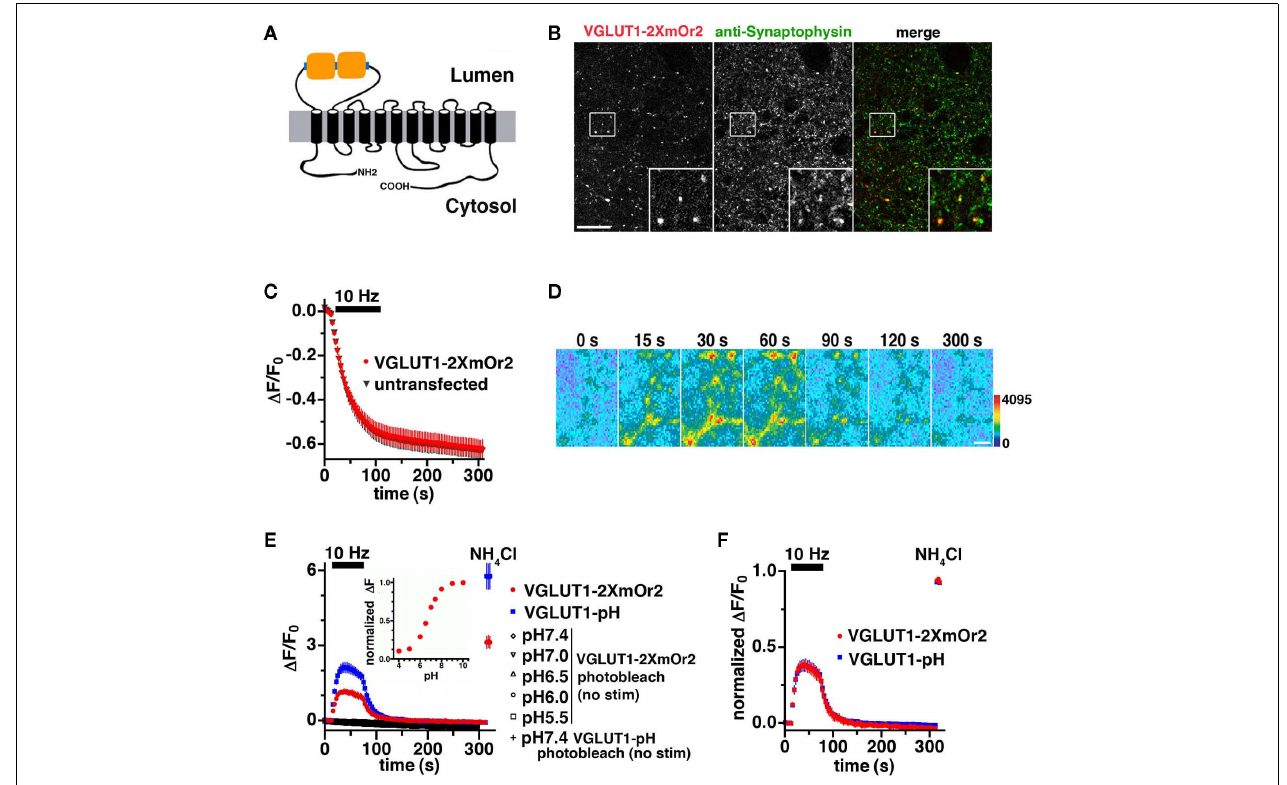
Scale bar, 2 μ m. (E) The change in fluorescence intensity over baseline ( Δ F / F 0 ) at boutons expressingVGLUT1-pH (blue) is approximately twice that ofVGLUT1-2XmOr2 (red) during stimulation at 10Hz for 60s (bar). Photobleaching over the time course of the experiment was measured by imaging in the absence of stimulation at a range of pH values (black symbols). Photobleaching ofVGLUT1-2XmOr2 (open diamonds) was similar to that ofVGLUT1-pH ( + symbol) at pH 7.4. Inset: normalized fluorescence change ofVGLUT1-2XmOr2 over the range of pH 4.0 to 10.0 in permeabilized cells indicatesVGLUT1-2XmOr2 exhibits a p K a of 6.71. (F) Kinetics of fluorescence changes normalized to total fluorescence signal in the presence of NH 4 Cl are similar forVGLUT1-pH (blue) and VGLUT1-2XmOr2 (red). Data in (C, E, and F) are means ± SEM of the change in fluorescence ( Δ F ) normalized to initial fluorescence (average of the first five data points, F 0 ) over at least 20 boutons per coverslip from 12 to 16 coverslips and at least three independent